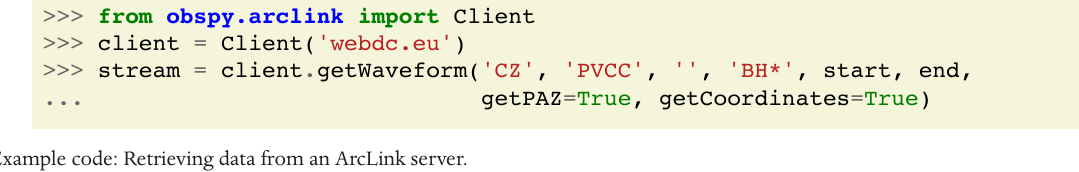
Figure 7. Example code: Retrieving data from an ArcLink server.